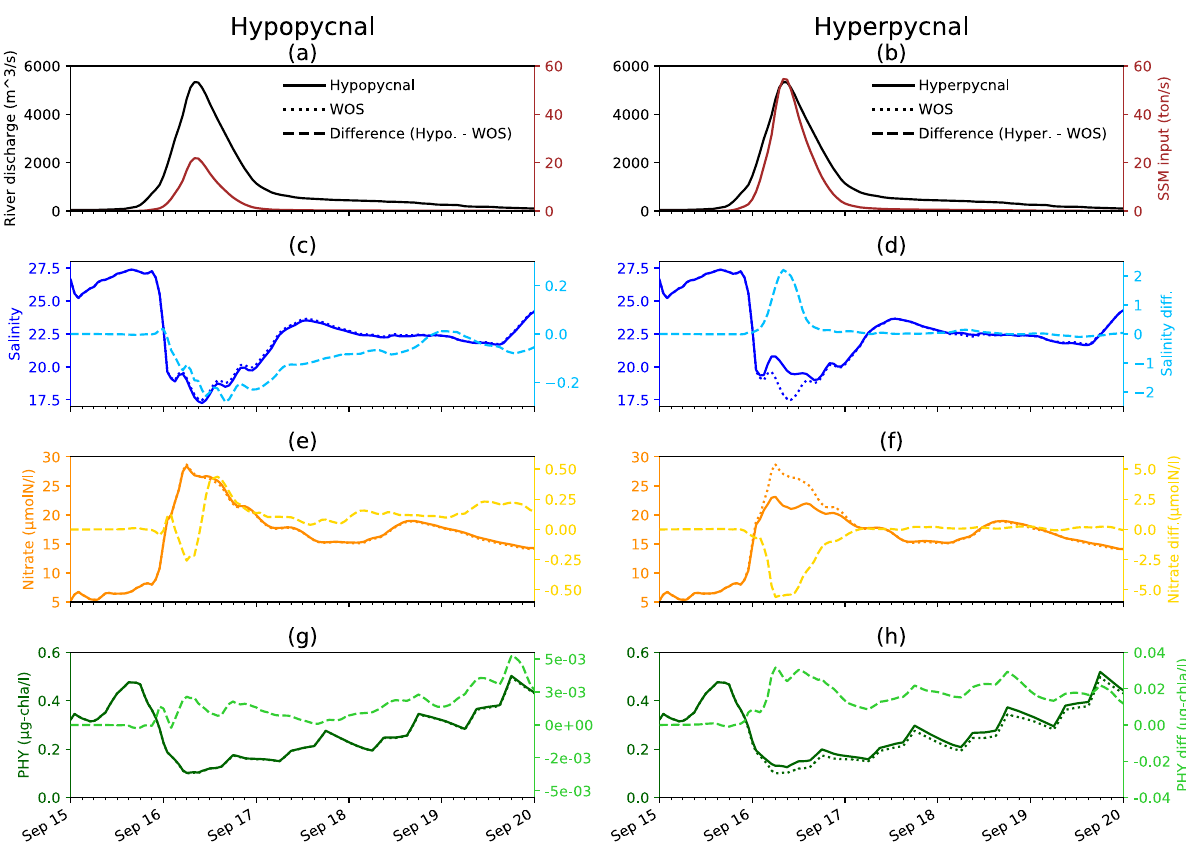
Figure 5. Left panels ( a , c , e , g ) illustrate the typical hypopycnal case (SSM input: 4, SSM diameter: 0.05 mm, nutrient input: 1 in Table 1). Right panels ( b , d , f , h ) show the typical hyperpycnal case (SSM input: 10, SSM diameter: 0.01 mm, nutrient input: 1 in Table 1). ( a , b ) Time series of river discharge (black lines; left y-axes) observed at Fukuchiyama, 37 km upstream from the mouth of Yura River, September 15–20, 2013 (Ministry of Land, Infrastructure, Transport and Tourism, Japan). Brown lines depict SSM input (right y-axes) to the river area. ( c ) Time series of salinity in the hypopycnal case (blue solid line; left y-axis), the WOS (blue dotted line; left y-axis), and the difference between the hypopycnal case and WOS (light blue dashed line; right y-axis) calculated in the surface (the top two layers) and river plume area (salinity ≤ 28.0) mean. ( d ) Time series of salinity in the hyperpycnal case (blue solid line; left y-axis), the WOS (blue dotted line; left y-axis), and the difference between the hyperpycnal case and WOS (light blue dashed line; right y-axis). ( e , f ) As ( c , d ), but for nutrient concentrations (yellow solid and dotted lines; left y-axes) and differences (light yellow dashed lines; right y-axes). ( g , h ) As ( c , d ), but for phytoplankton concentrations (green solid and dotted lines; left y-axes) and differences (light green dashed lines; right y-axes). Note that the scales of the right y-axes in ( c , d ), ( e , f ), and ( g , h ) are different by approximately one order of